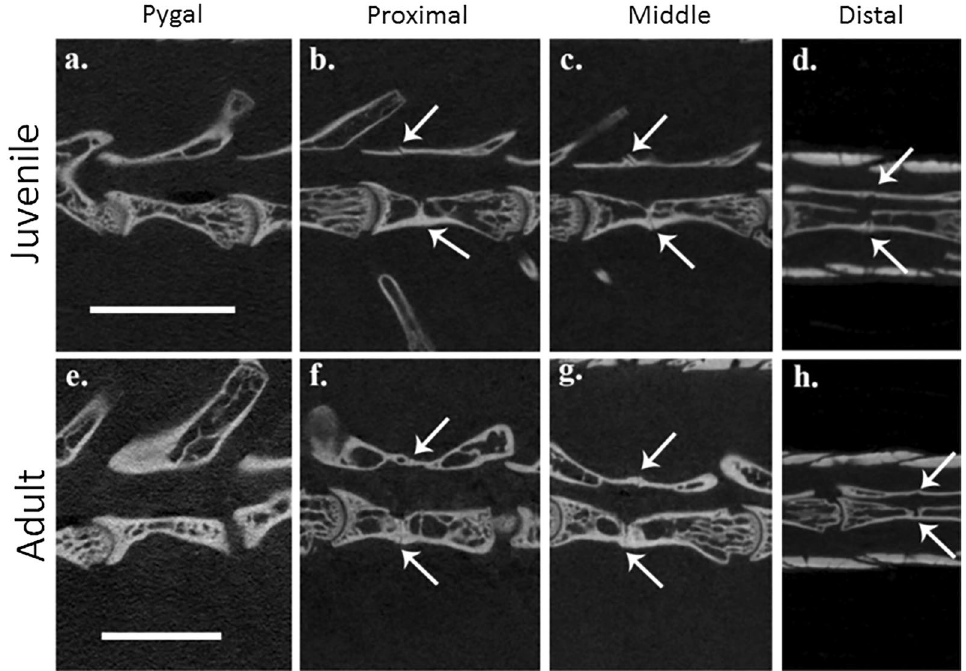
Figure 1. Sagittal longitudinal sections of Egernia kingii caudal vertebrae from reconstructed micro-CT images showing fracture planes (arrows) in the neural arch (top arrows) and centrum (bottom arrows). Images for a juvenile (top row) specimen (R62232) and an adult (bottom row) specimen (RI adult). Pygal vertebra without fracture planes and post-pygal vertebrae with fracture planes at proximal, middle, and distal positions of the tail (a., b., c., d. for the juvenile and e., f., g., h for the adult). White bar represents 5 mm for the individual